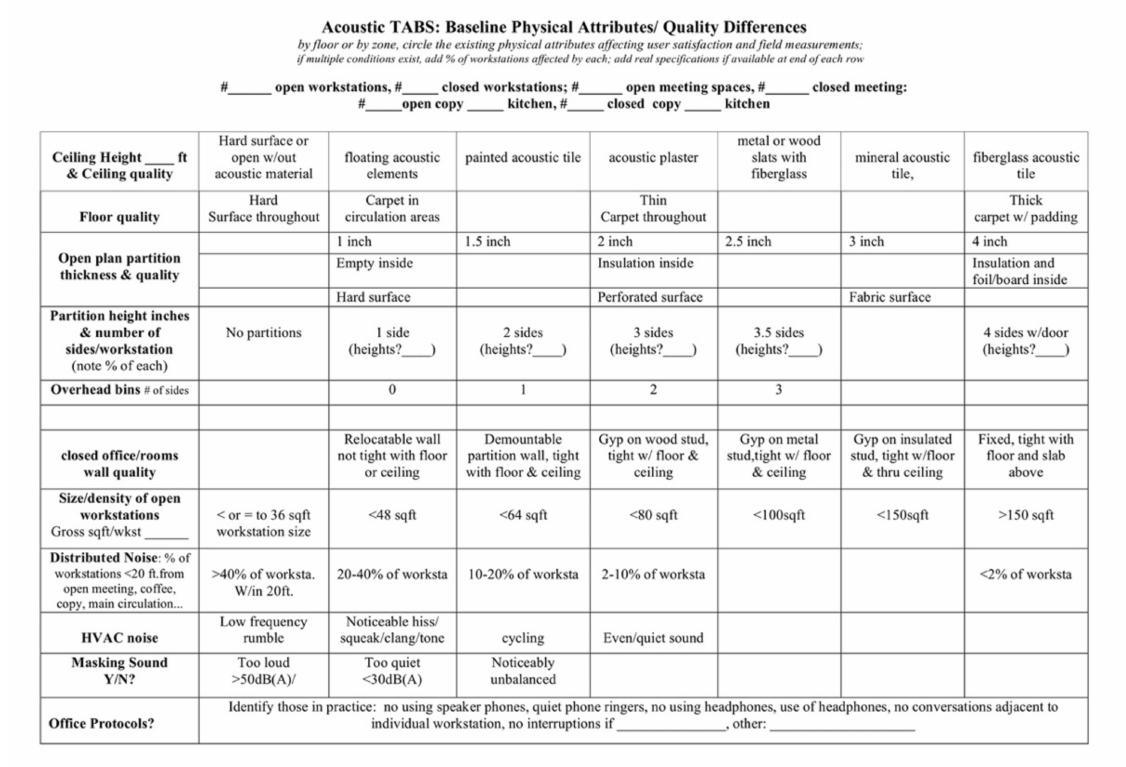
Figure A1. Acoustic TABS worksheet.